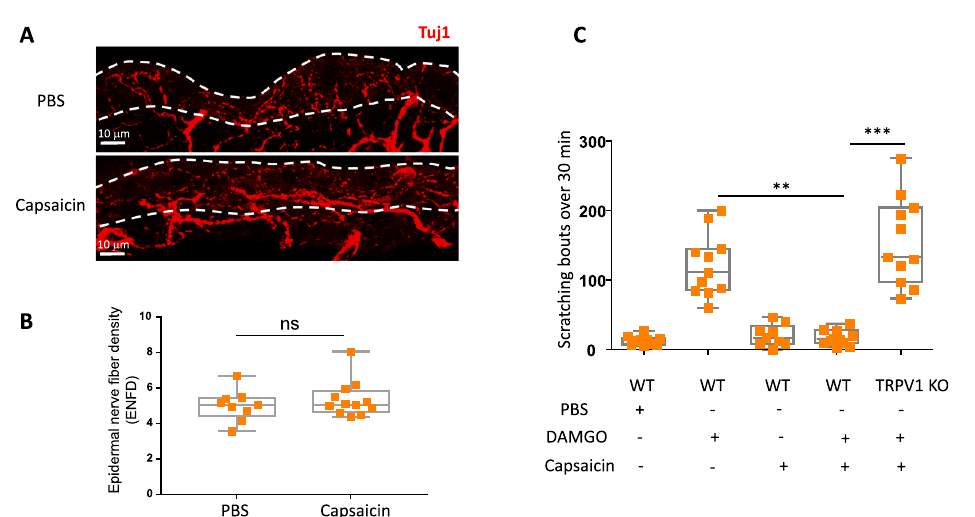
Figure 6. Acute injection of capsaicin prevents DAMGO–induced itch. ( A ) Representative images and ( B ) quantification of intraepidermal Tuj1 + nerve fiber density per 100 μ m of skin tissue, between PBS and capsaicin (0.05%) treated mice. Dotted line delineates the epidermis. Statistical analysis were performed using Mann Whitney U test. ( C ) Scratching bouts evoked by intradermal injections of either PBS or DAMGO (200 µ M) in WT (PBS; n = 10, DAMGO; n = 11), capsaicin pre-injected mice (PBS; n = 9, DAMGO; WT n = 11 and TRPV1 deficient mice n = 11). Results are represented as Whisker-dot plot (Min-Mean-Max) and each symbol represents an individual mouse. Statistical analysis were performed using Kruskall-Wallis followed by post-hoc Dunn’s test ( ** p < 0.01 WT + DAMGO versus capsaicin + DAMGO and *** p < 0.001 capsaicin + DAMGO in WT versus TRPV1 KO